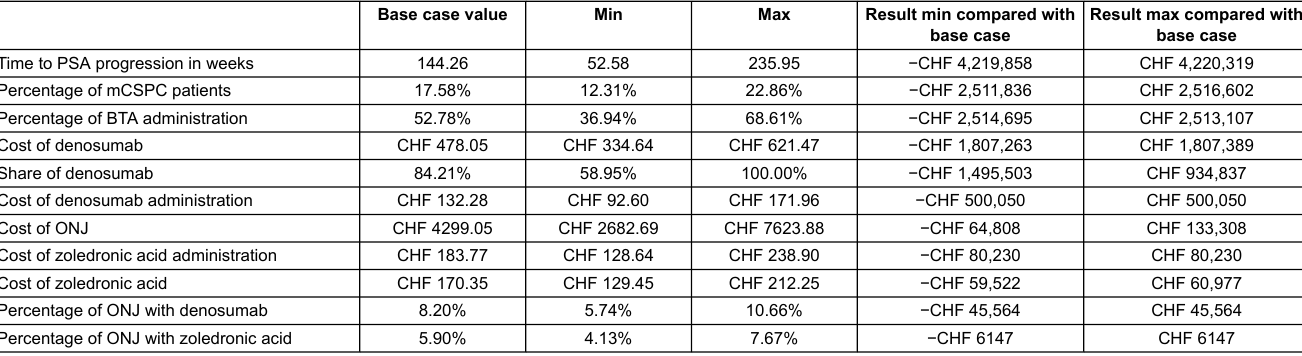
Table 5: Sensitivity analysis for total costs, performed by varying certain model